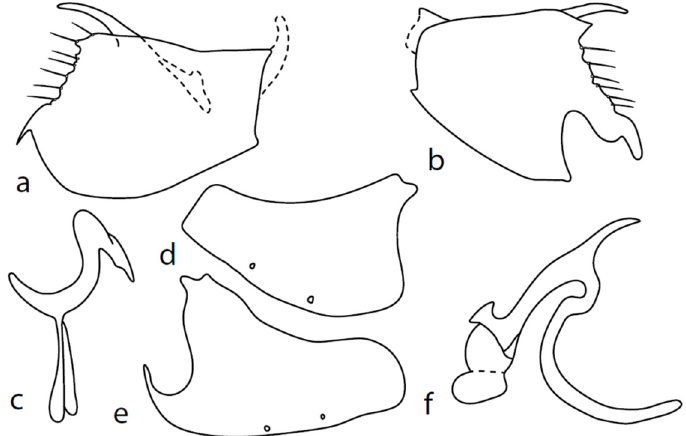
Figure 2. M. baechlii sp. nov.: ( a ) = right epandrial lamella, ( b ) = left epandrial lamella, ( c ) = postgonites from left, ( d ) = hypandrium from left, ( e ) = hypandrium from right, ( f ) = phallus from left. Dots on ( d , e ) are insertion points of large macrochaetae.